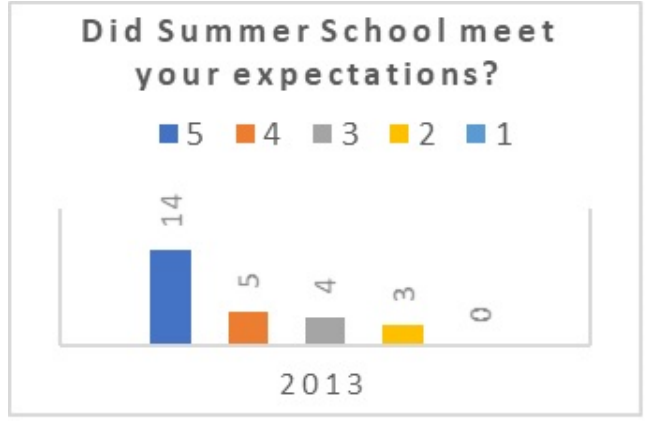
Figure 1. The first Summer School survey results, 2013 (answers on the scale from 5—fully to 1—not at all).